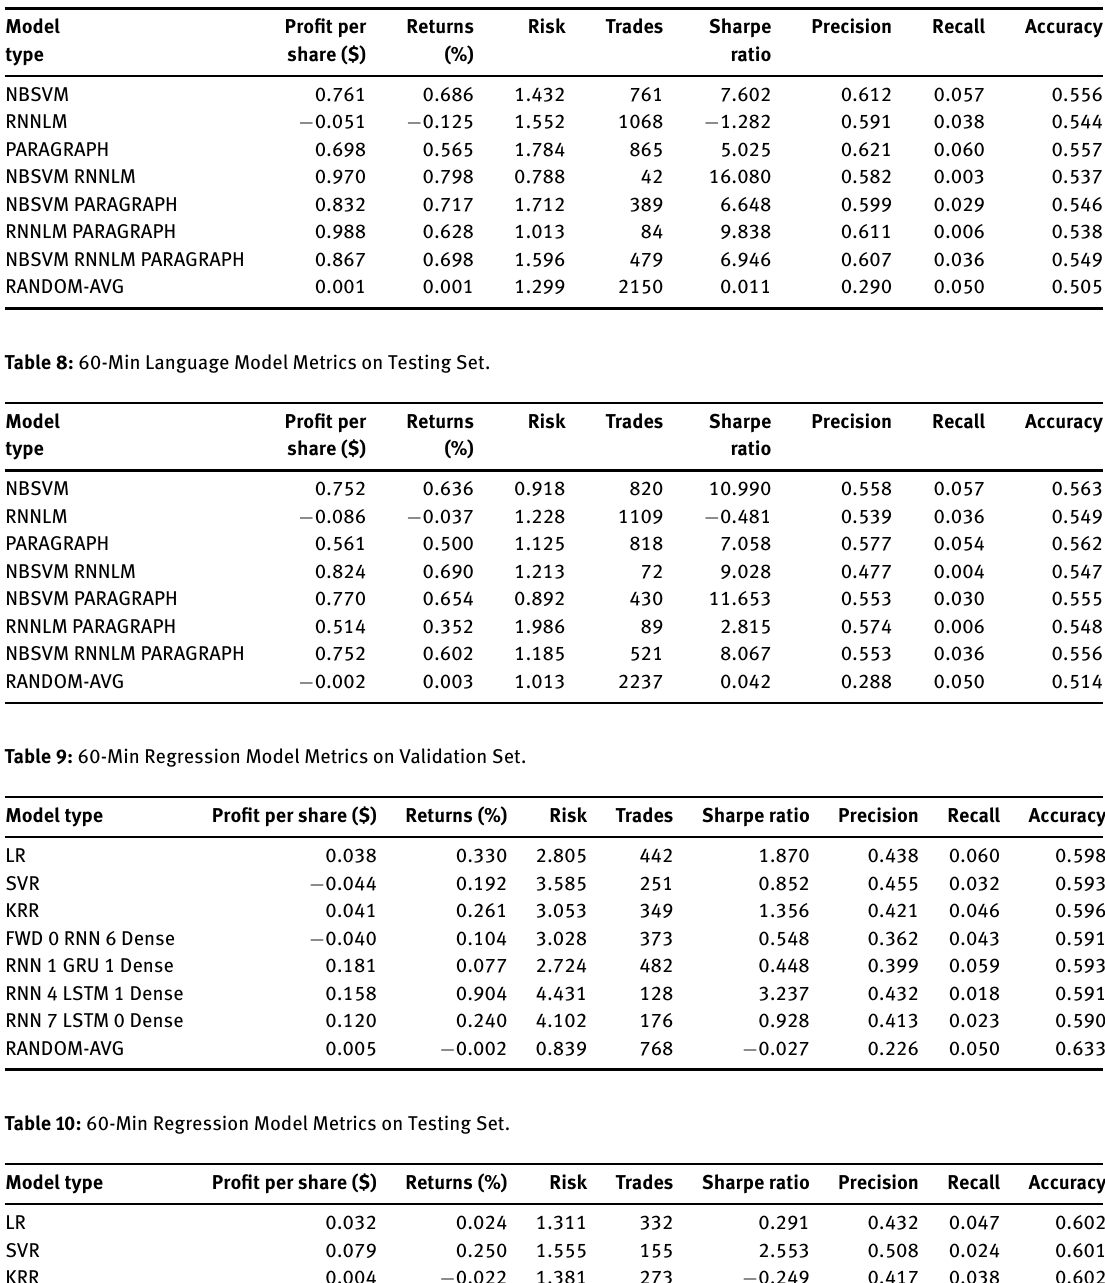
Table 7: 60-Min Language Model Metrics on Validation Set.